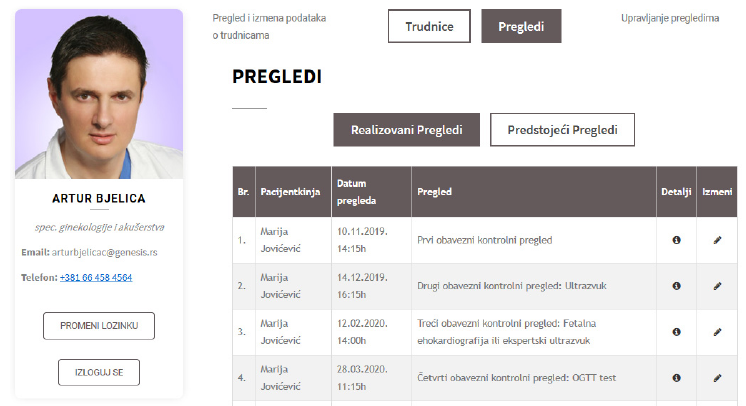
Figure 7 . Web application — doctor’s dashboard.